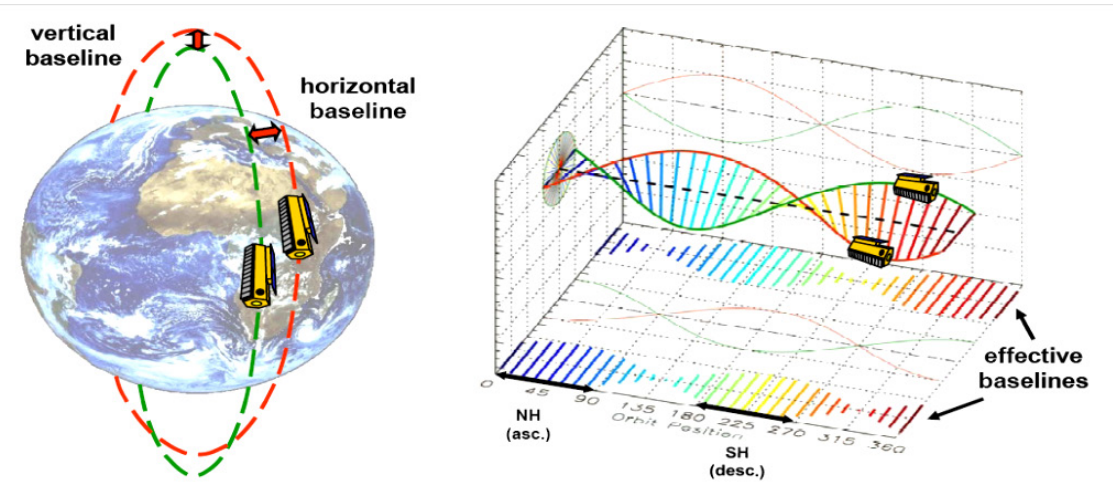
Fig. 1: The Helix configuration of the two satellites leads to varying horizontal and vertical baselines. Therefore, the effective baseline for DEM extractions is a function of latitude (TanDEM Science Plan, courtesy of